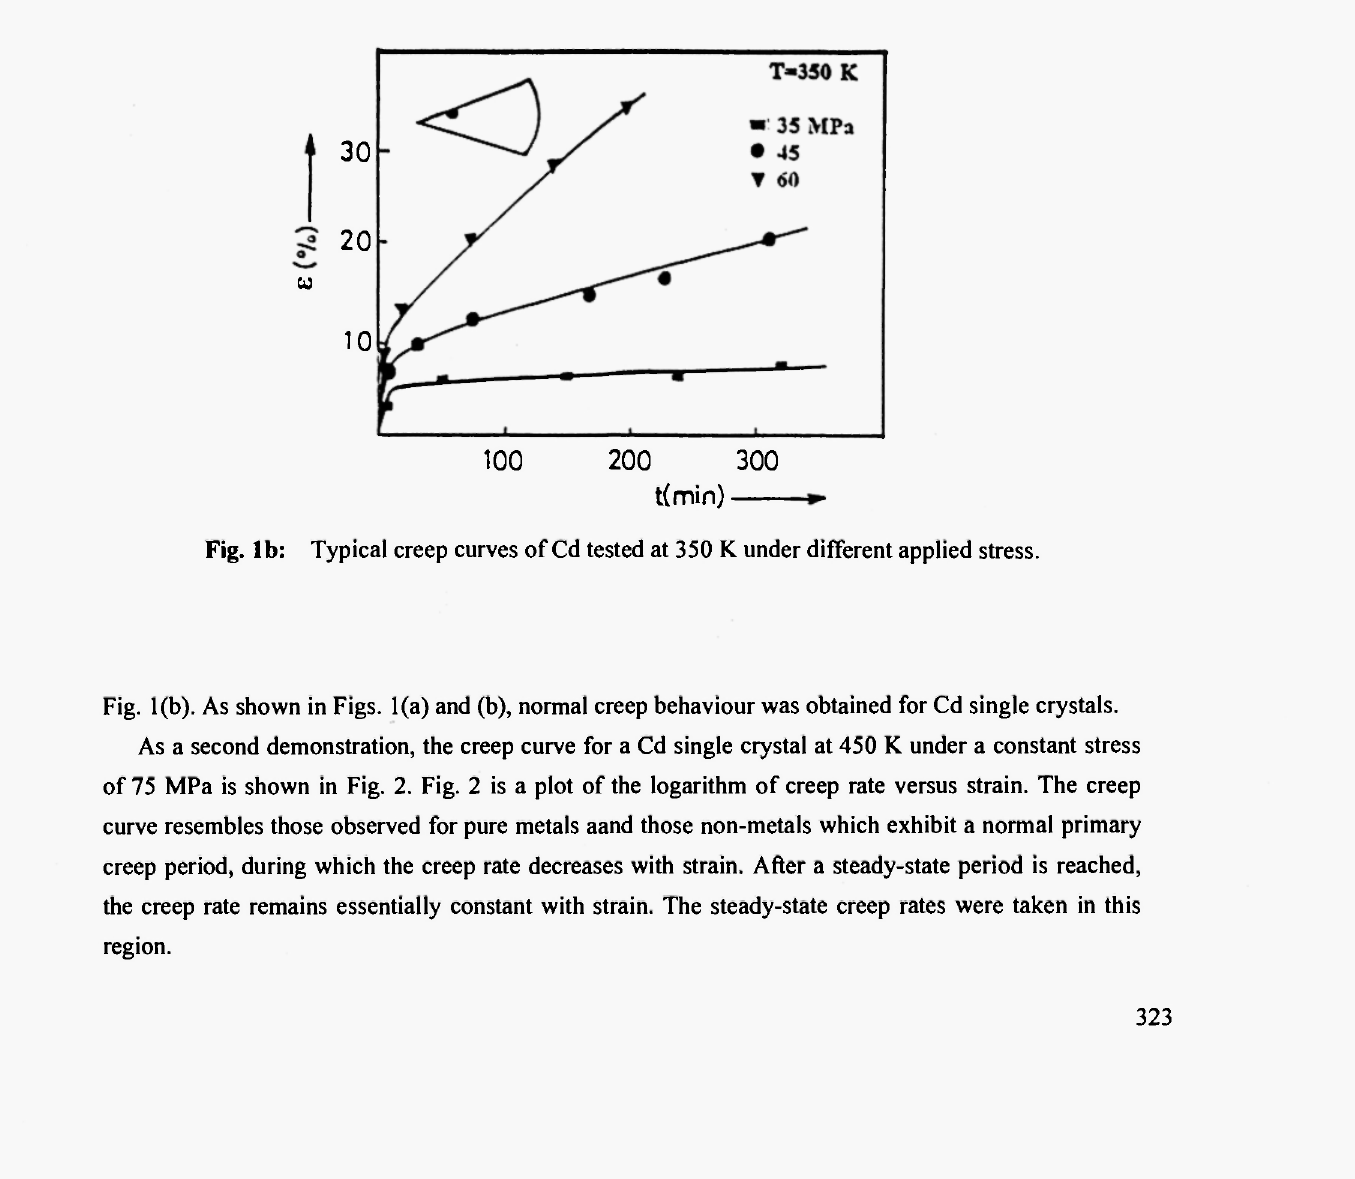
Fig. 1 a: Typical creep curves of Cd tested at 75 MPa at different temperatures.